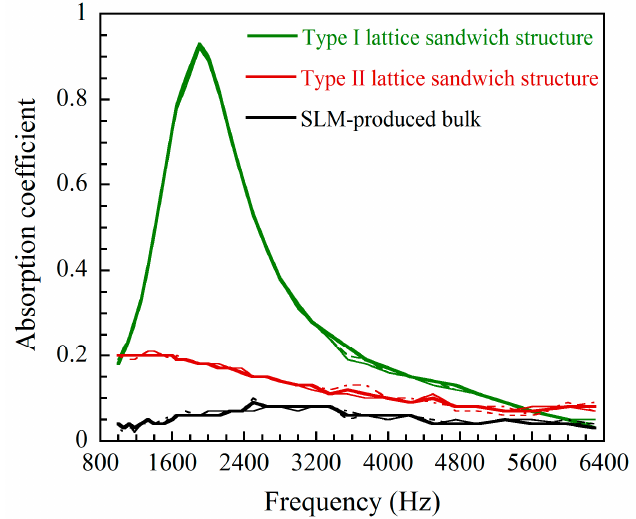
Figure 9. Sound absorption property curves of the three different structural acoustic specimens. (The thin line curves and dotted line curves in this figure are the octave spectrums of each group of sound absorption property test. The three heavy line curves in this figure are the average value curves of the octave spectrums of the three structures.).